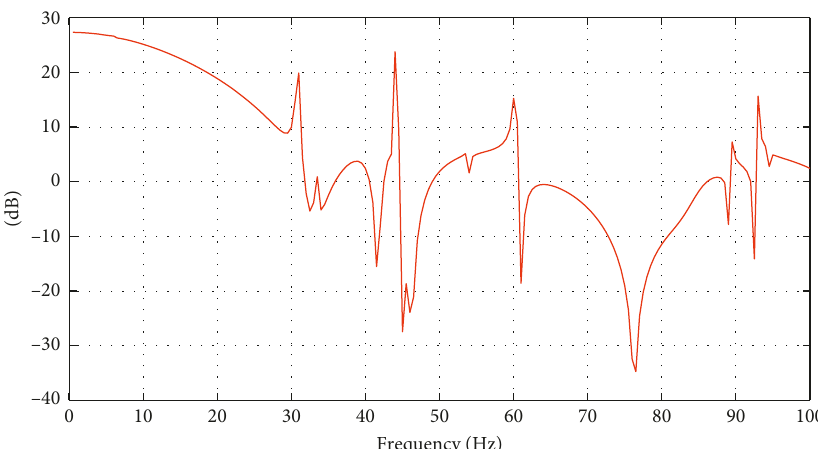
Figure 17: FEM Transmissibility in Y -direction between lower and upper platen.